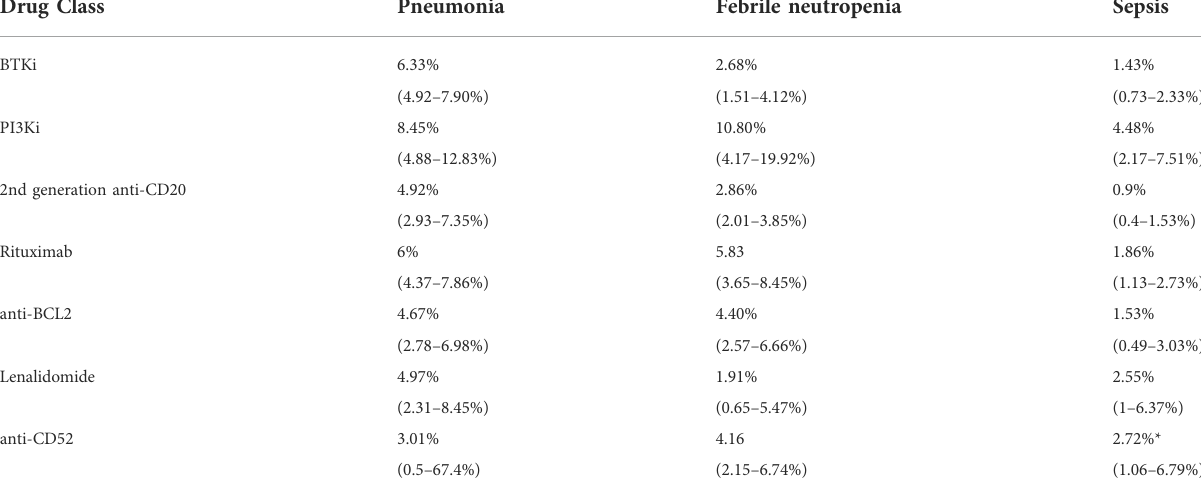
TABLE 2 Secondary